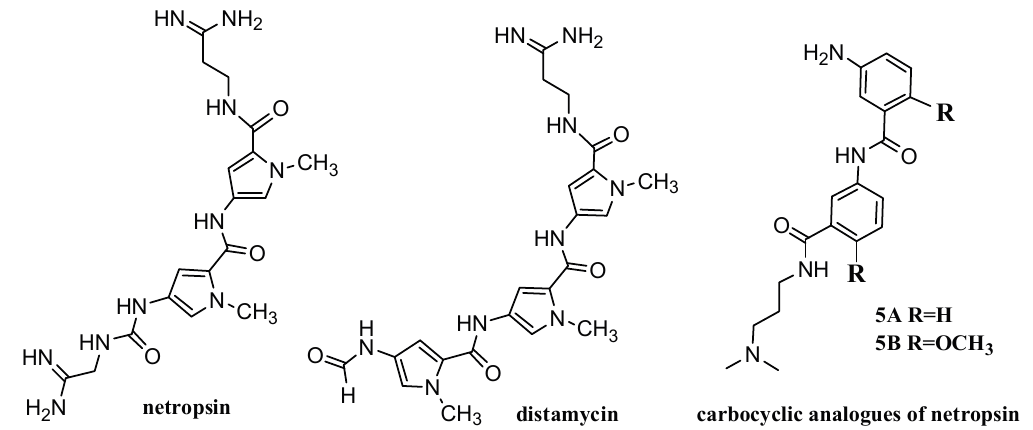
Figure 1. Structures of netropsin, distamycin and carbocyclic analogues of